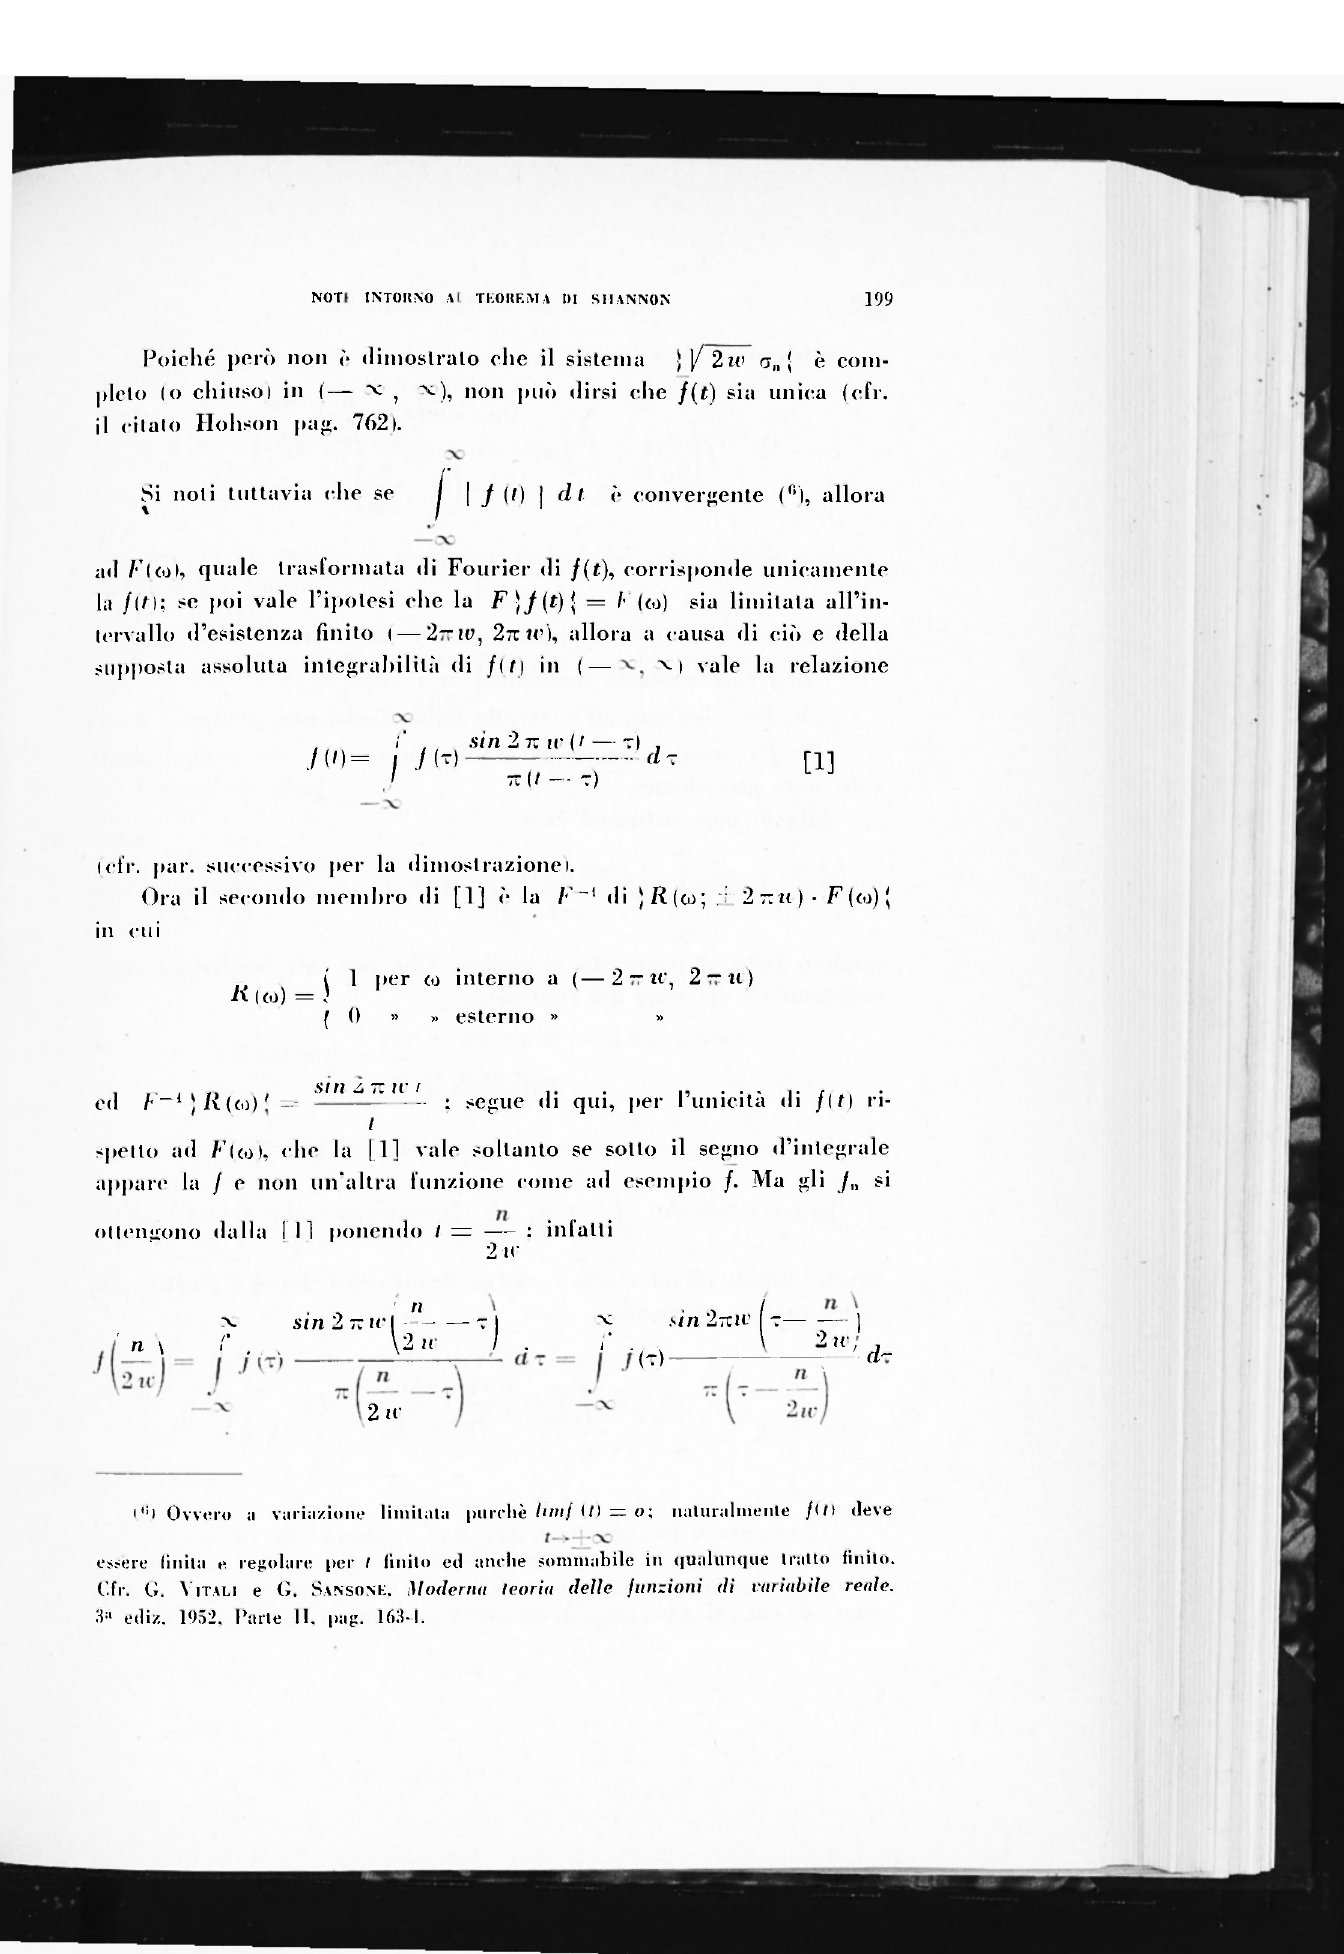
(."l Ovvero a variazione limitata purché /ini/ U) = o; naturalmente f(t) lieve essére finita e regolare per t finito ed anche sommabile in qualunque tratto finito. Cfr. G. VITALI e G. SANSONE.